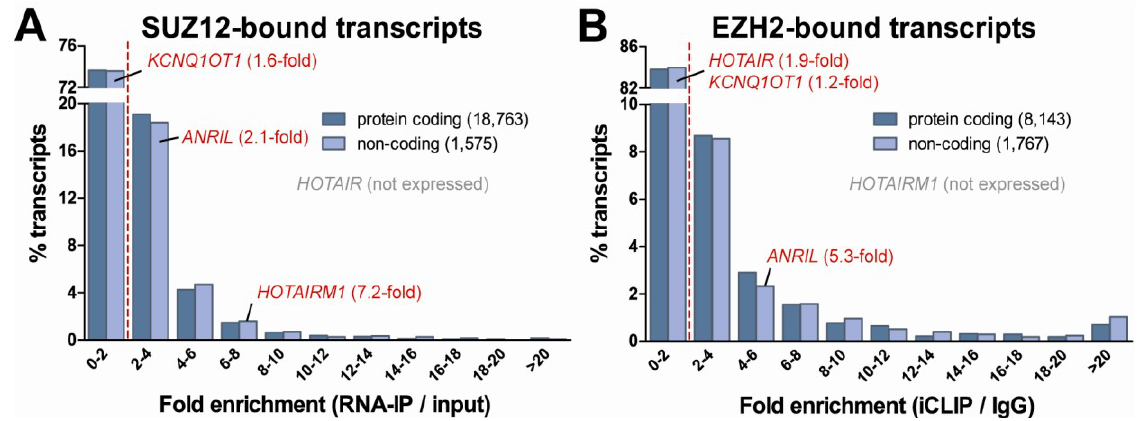
Figure 3. RNA binding to PRC2 complex components. ( A ) Analysis of data from our lab showed that both mRNAs and lncRNAs bind to the PRC2 complex component SUZ12 with similar binding affinities [183]. For comparison, known lncRNA-PRC2 interactions and their fold enrichments are shown in red. Here, the RNA-IP experiments were performed on the prostate cancer cell line LNCaP upon formaldehyde-fixation; ( B ) Reanalysis of the raw data from the Guil et al . confirmed our finding that both protein-coding and non-coding RNA can bind with high affinity to the PRC2 complex, in this case the EZH2 subunit [29]. These data were obtained from UV cross-linking experiments (iCLIP) in the colorectal cancer cell line